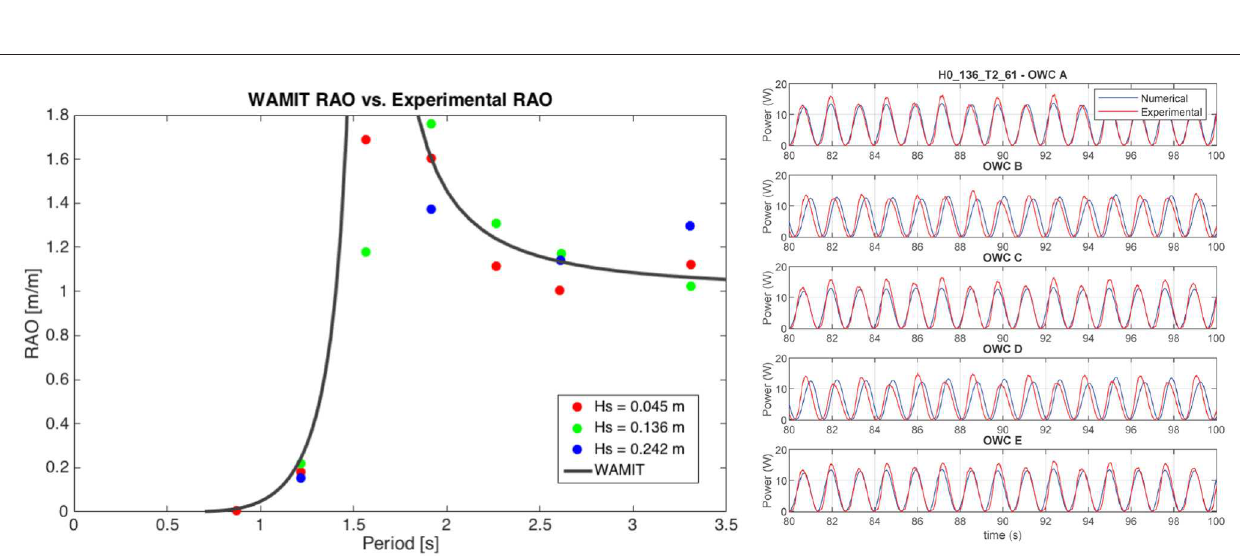
Frontiers in Energy Research |